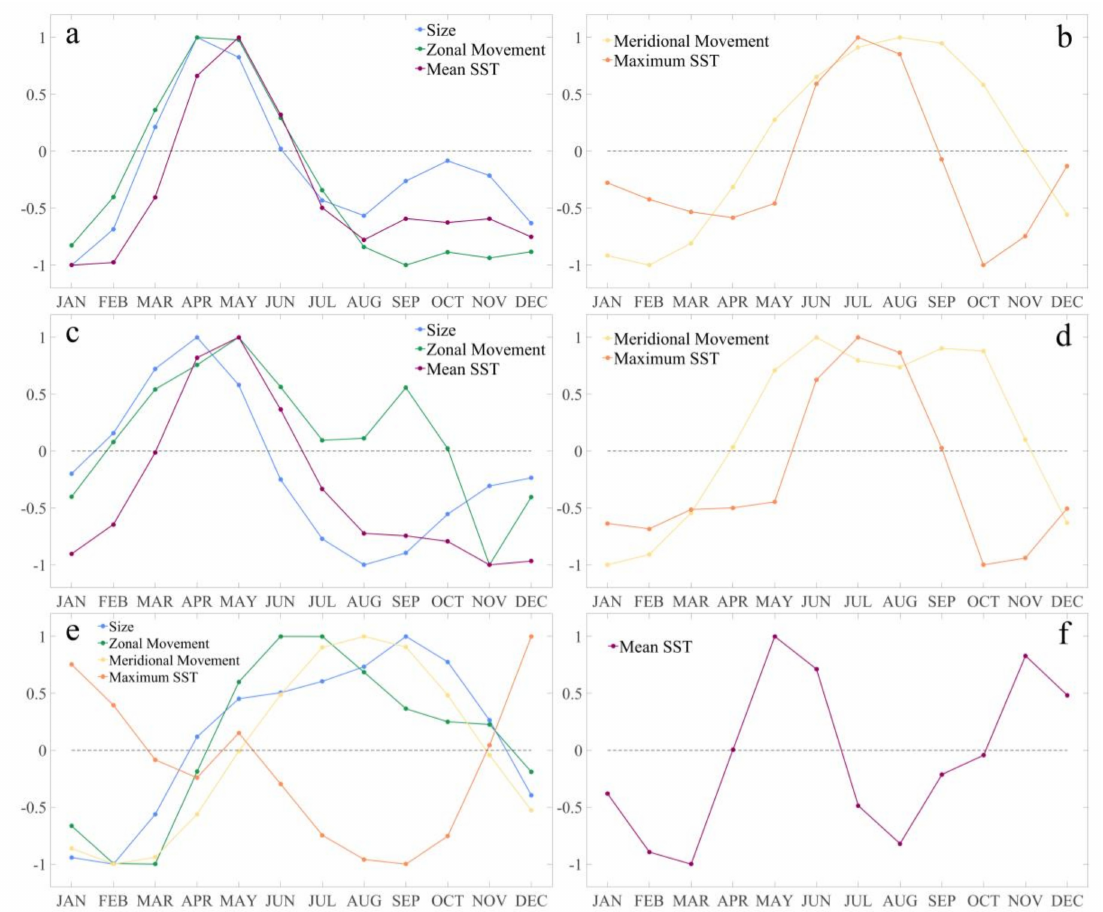
Figure 5. Annual cycles of normalized ( a , b ) IPWP properties; ( c , d ) IW properties; ( e , f ) PW